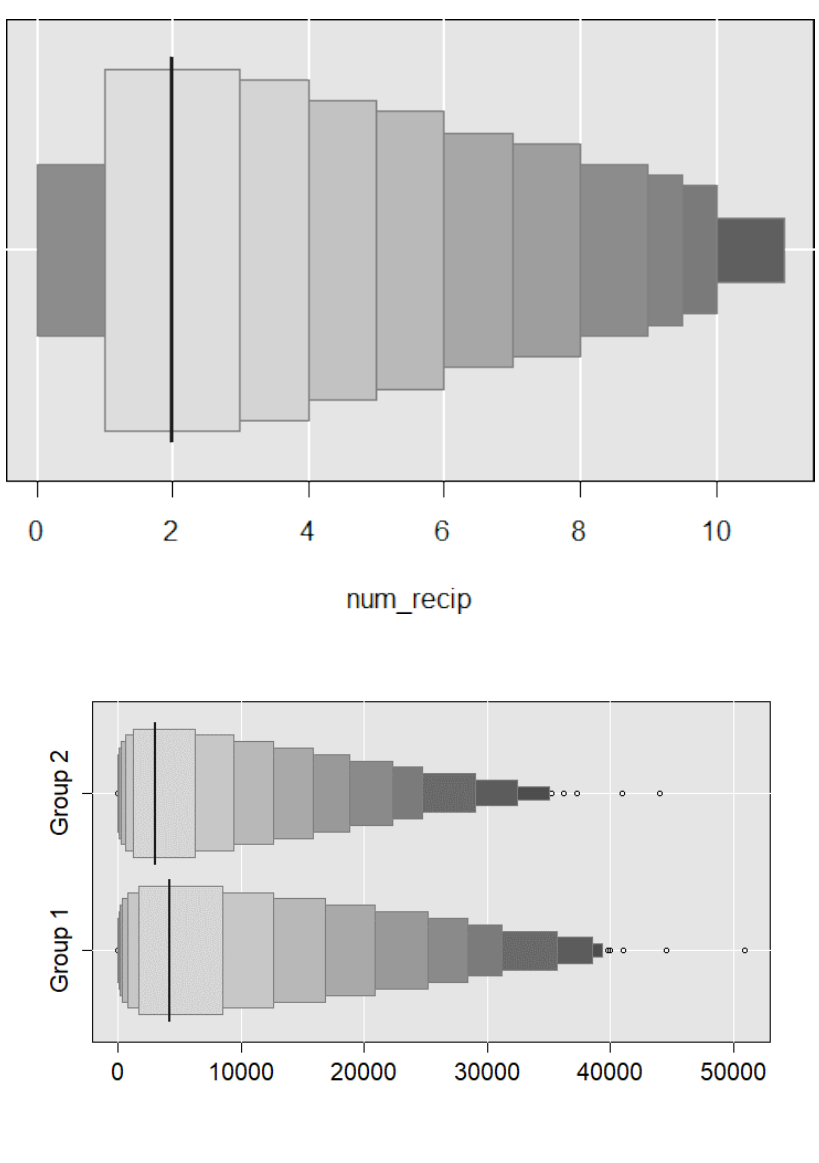
Figure 1: Example letter-value plots for simulated